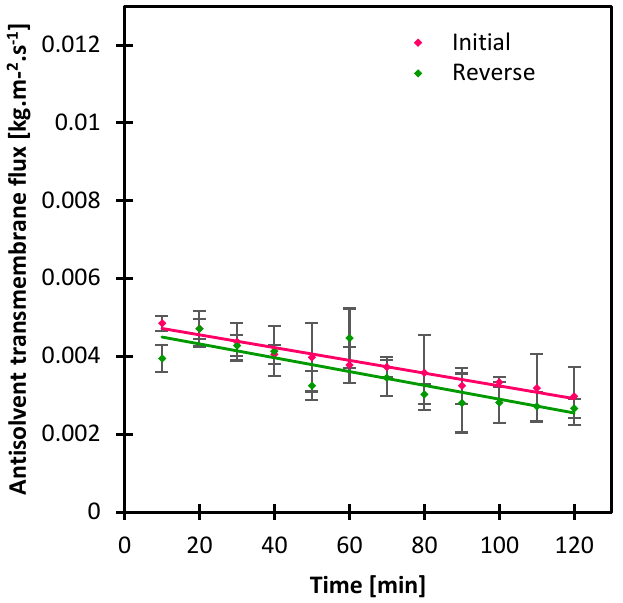
Figure 10. Antisolvent transmembrane flux with variation of gravity impact.